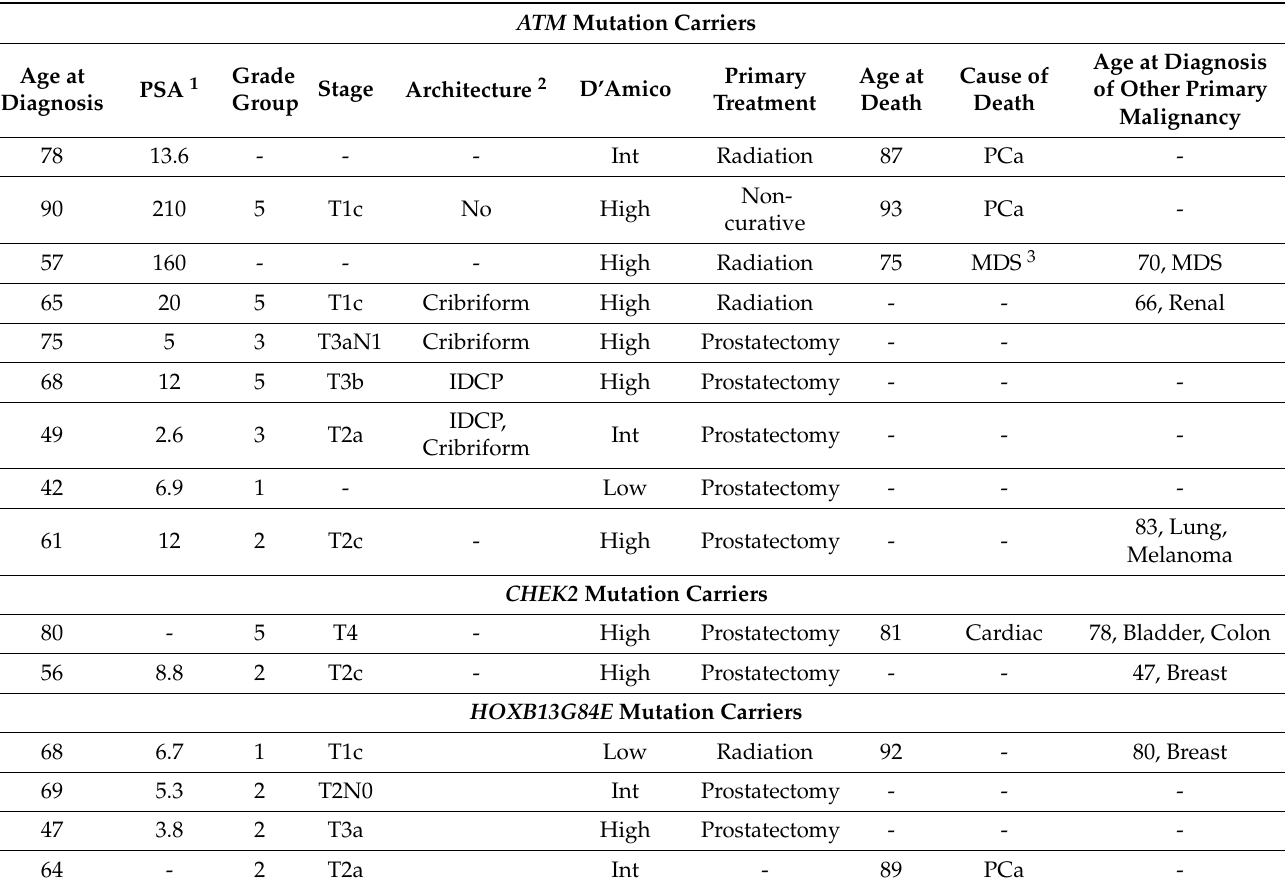
Table 2. Clinical characteristics for ATM , CHEK2 , and HOXB13 germline